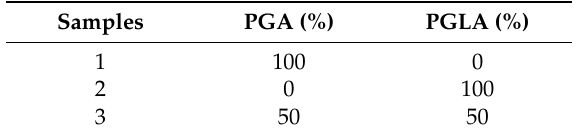
Table 1. Compositions of the stents.